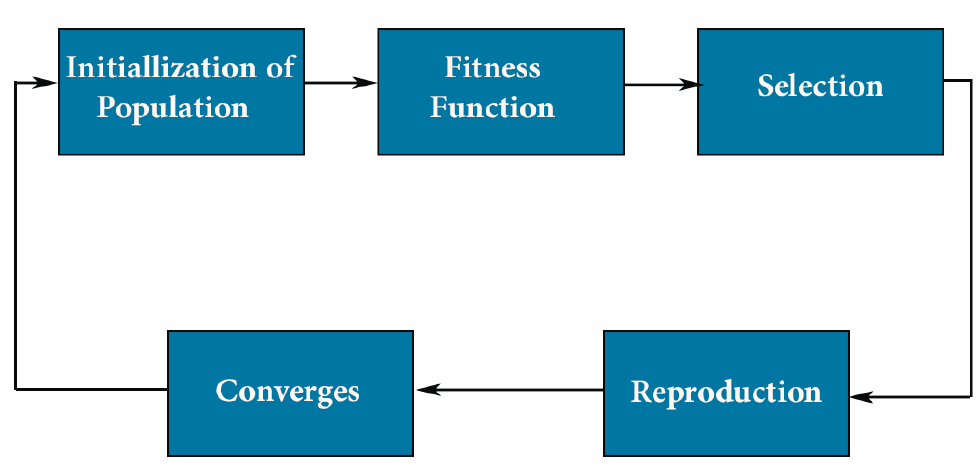
Figure 4. Architecture of the genetic algorithm.